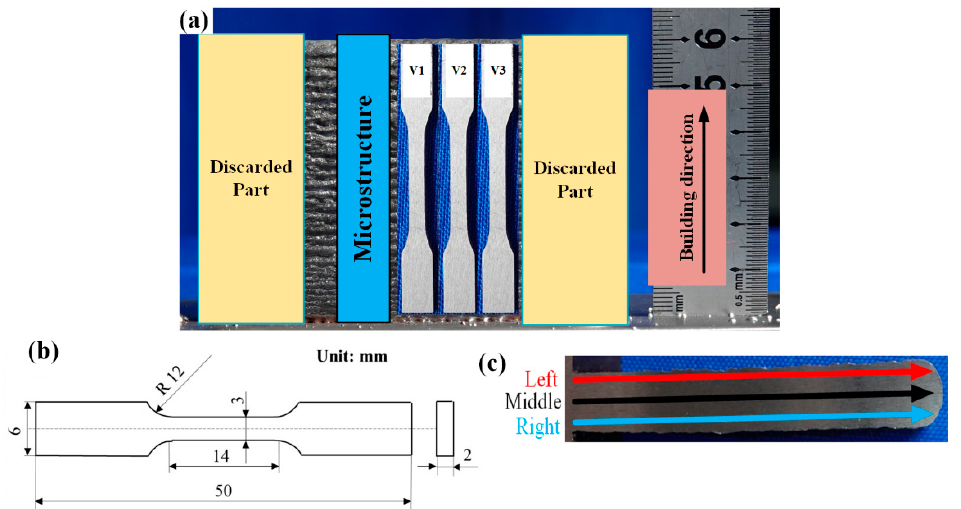
Figure 3. Sampling size and measuring position: ( a ) Extraction locations of microstructure and tensile samples on each wall; ( b ); Tensile specimen sizes; ( c ) Test position of